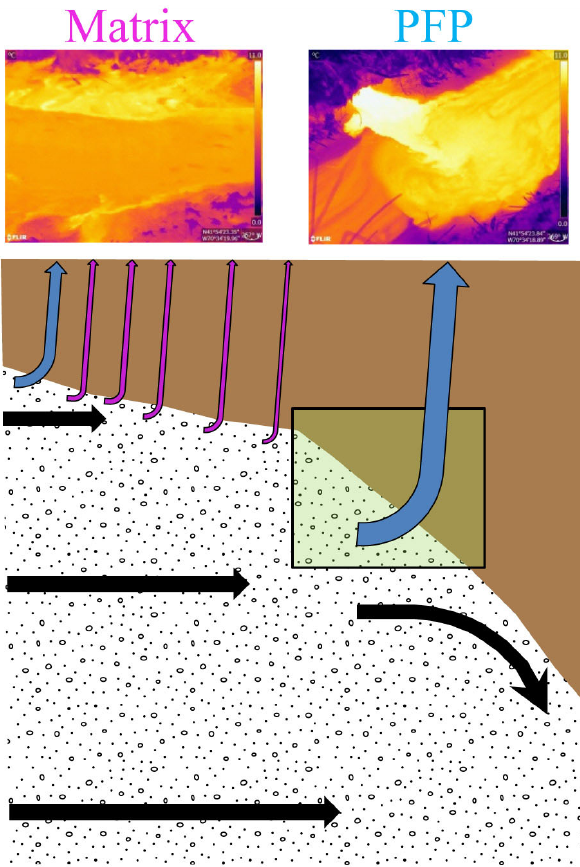
Figure 9. Conceptual model illustrating the mechanism for devel- opment of matrix (type 1) seepage (pink arrows) and preferential flow path (PFP) or interior (type 2) seepage (blue arrows), corre- sponding to locations in winter TIR images. Thick black lines repre- sent groundwater flow direction, and the yellow-green box indicates the region of high basin curvature. The brown basin represents peat in a typical basin shape based on GPR line 7.1 (Fig. 2c). Conceptual matrix and PFP seepage locations are based on the temperature data recorded proximal to GPR line 7.1 and winter TIR images from this same transect. PFP seeps found in the thicker peat are associated with locations of high basin curvature where strong vertical gradi- ents drive focused, higher-flux seepage through pre-existing weak- nesses in the peat